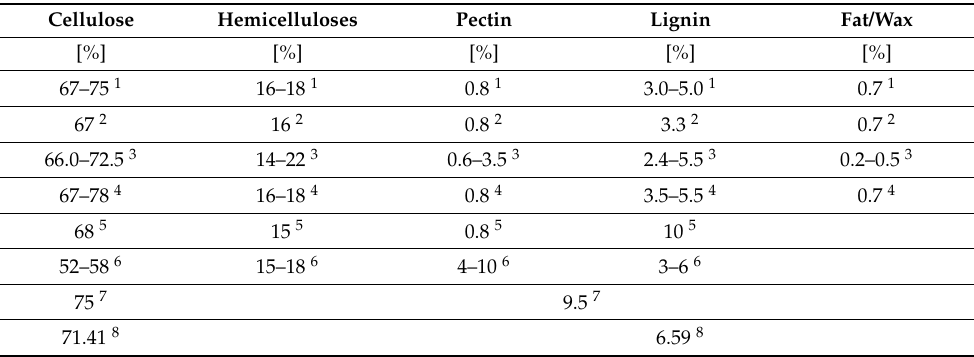
Table 1. Chemical composition of hemp fibres based on the different literature resources 1 [43], 2